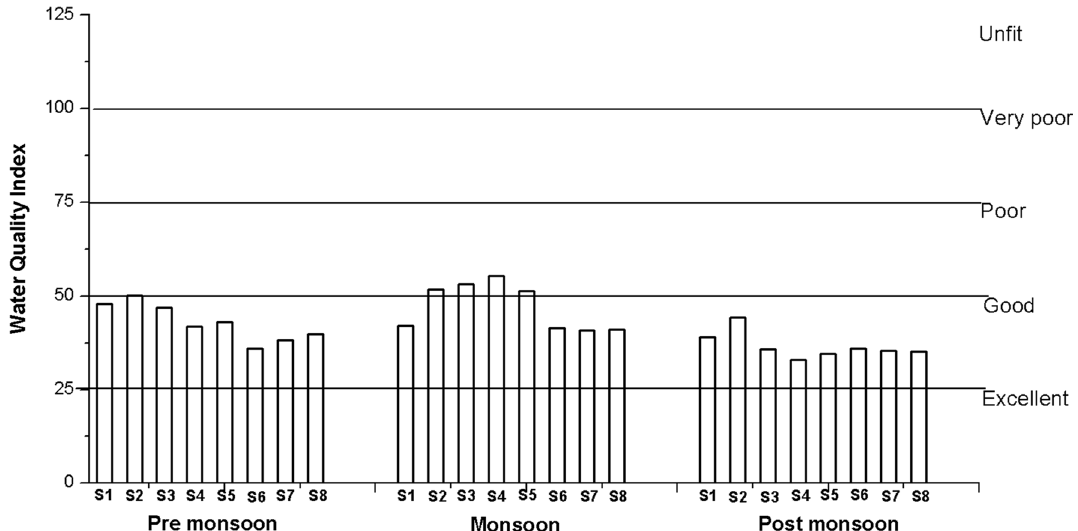
Fig. 4 WQI value of various sampling stations showing a varied pattern of change across